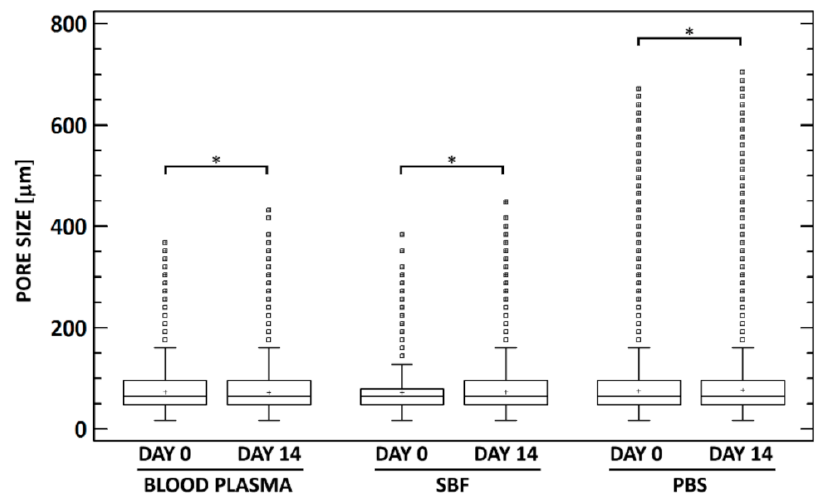
Figure 4. Comparison of the pore size values for all three groups prior to and following exposure. Only minor differences can be observed in terms of porosity volume, pore size, and pore distribution. * denotes statistically significant differences (Mann–Whitney, n = 20, 0.05 ).